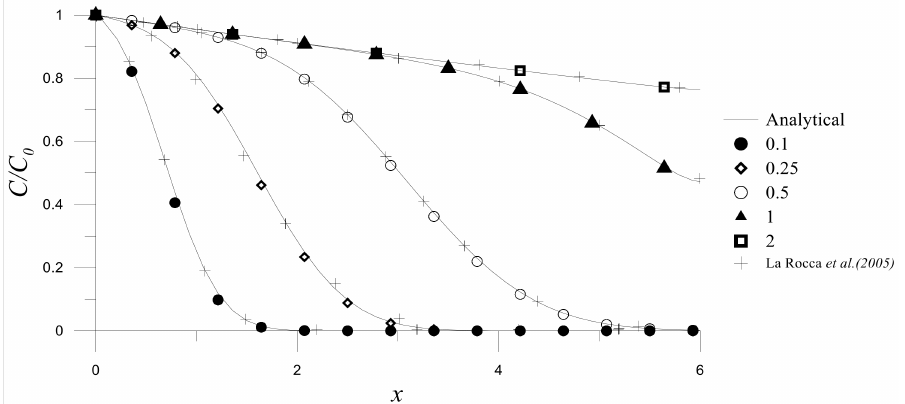
Figure 13. Comparisons between the numerical results of Hermite MAPS, the analytical solutions and the results in the literature for Example